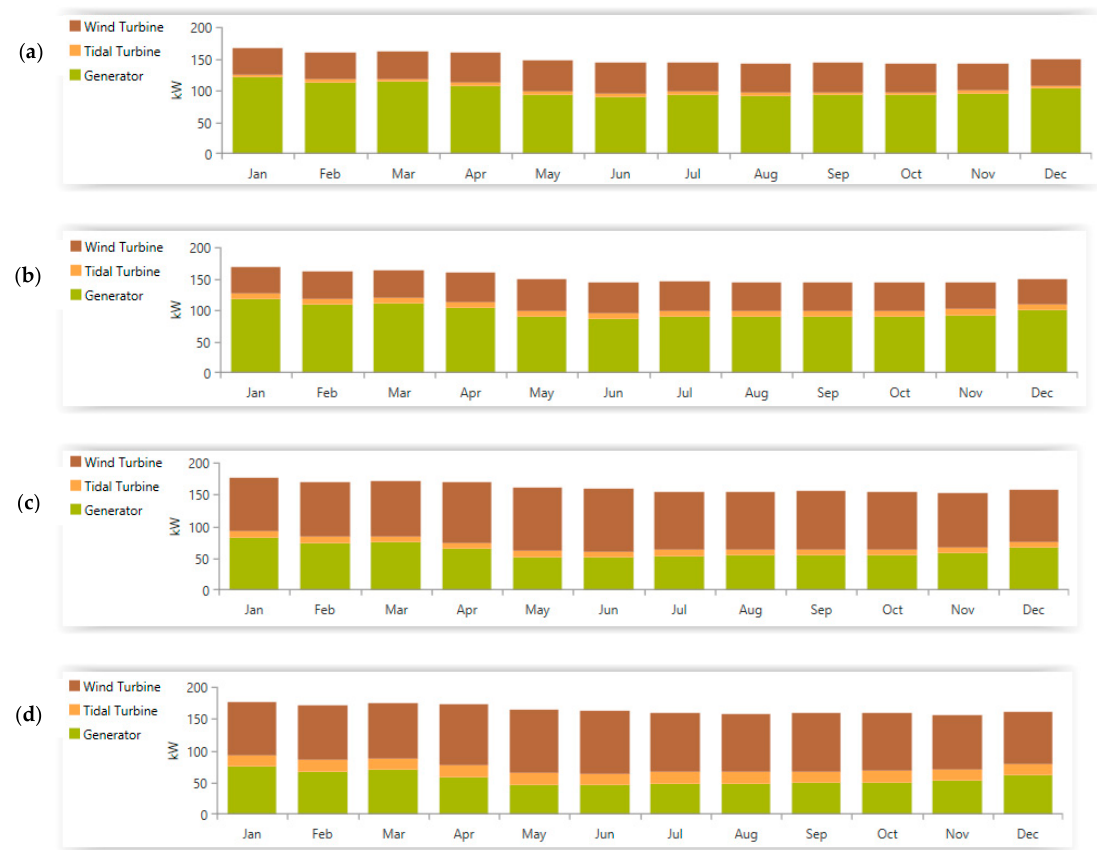
Figure 15. Monthly average output power for ( a ) 1W + 1T, ( b ) 1W + 2T, ( c ) 2W + 2T, ( d ) 2W + 4T. Table 6. Share of wind and tidal turbines in electricity production.